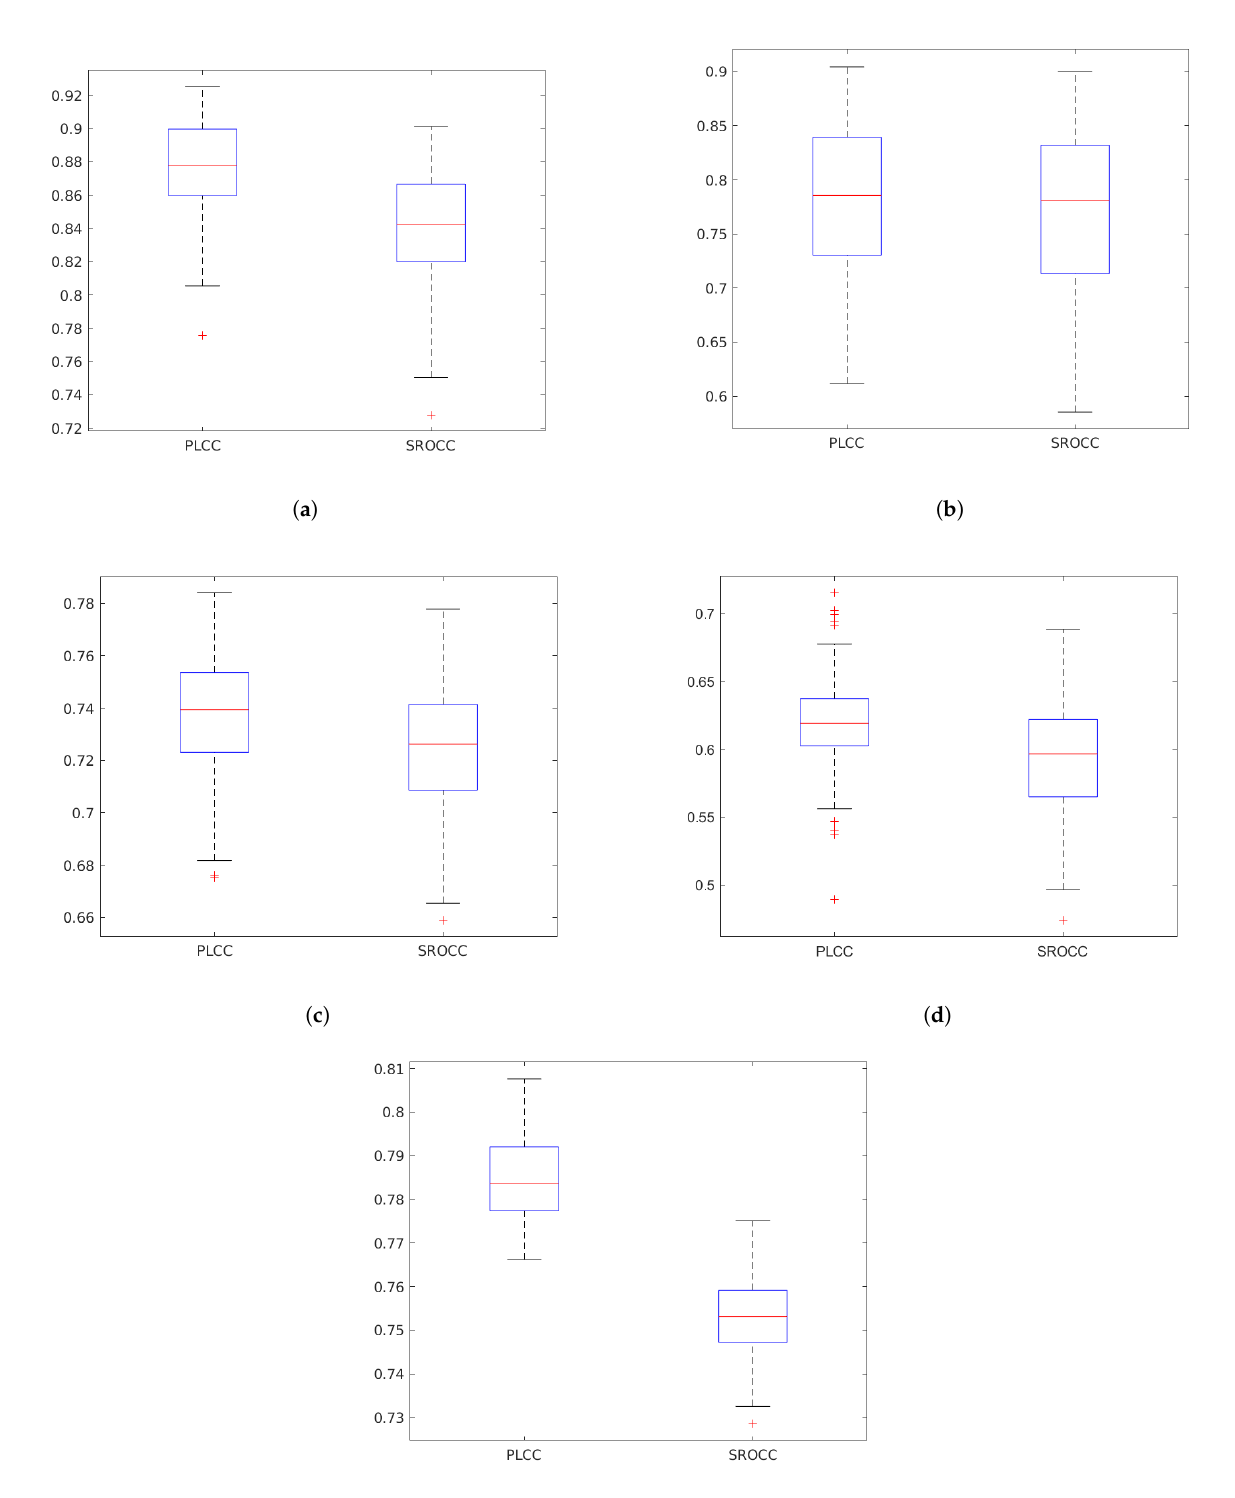
Figure 6. Box plots of the PLCC and SROCC values produced by GSF-IQA on five IQA benchmark databases (CSIQ [58], MDID [59], KADID-10k [46], LIVE In the Wild [35], and KonIQ-10k [60]). Measured over 100 random train–test splits. ( a ) CSIQ [58]. ( b ) MDID [59]. ( c ) KADID-10k [46]. ( d ) LIVE In the Wild [35]. ( e ) KonIQ-10k